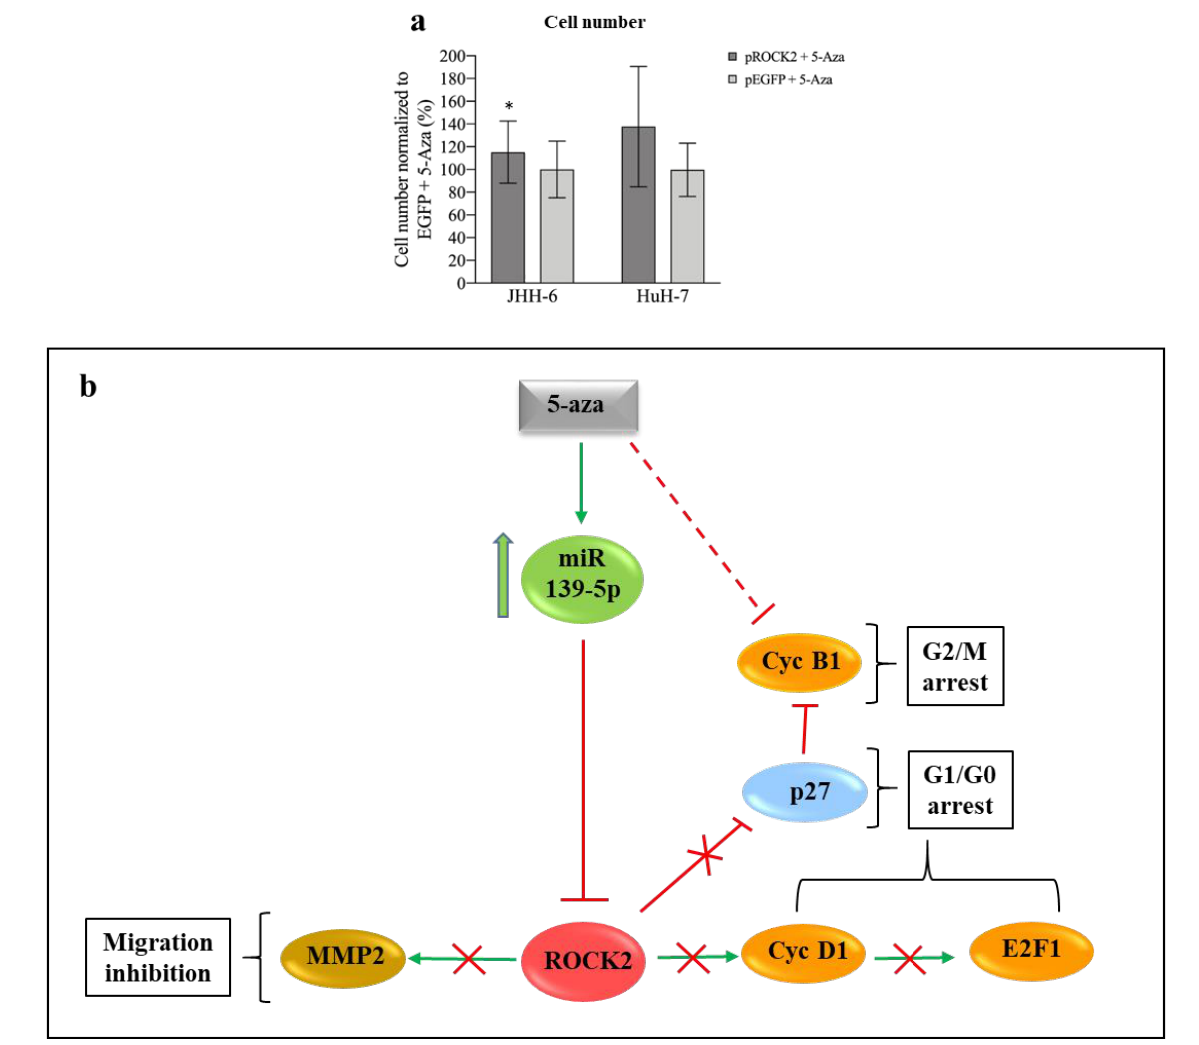
Figure 5. Phenotypic effects of ROCK2 overexpression/downregulation and miR-139-5p/ROCK2 pathway. ( a ) ROCK2 overexpression and 5-Aza treatment. Left: data in %, normalized to the average of JHH-6 overexpressing EGFP (enhanced green fluorescent protein, control cells) + 5-Aza treatment (0.8 µ M), are expressed as mean ± SEM, n = 4; JHH-6 overexpressing ROCK2 + 5-Aza vs. JHH-6 overexpressing EGFP + 5-Aza, * p = 0.035. Right: HuH-7 overexpressing ROCK2 + 5-Aza vs. HuH-7 overexpressing EGFP + 5-Aza (6 µ M); data in %, normalized to the average of HuH-7 overexpressing EGFP + 5-Aza, are expressed as mean ± SEM, n = 3. ( b ) Molecular pathways regulated by miR-139-5p and effects on cell migration and proliferation: 5-Aza upregulates miR-139-5p, which in turn leads to the downregulation of ROCK2/cyclin D1/E2F1/cyclin B1/MMP-2 and the upregulation of p27 kip 1; this results in G1/G0-G2/M cell cycle arrest and in the impairment of cell migration. 3.2.4. Involvement of CyD1 and E2F1 in 5-Aza Induction of Cell Accumulation in G1 Phase ROCK2 promotes the transition to the G1/S phase via the upregulation of